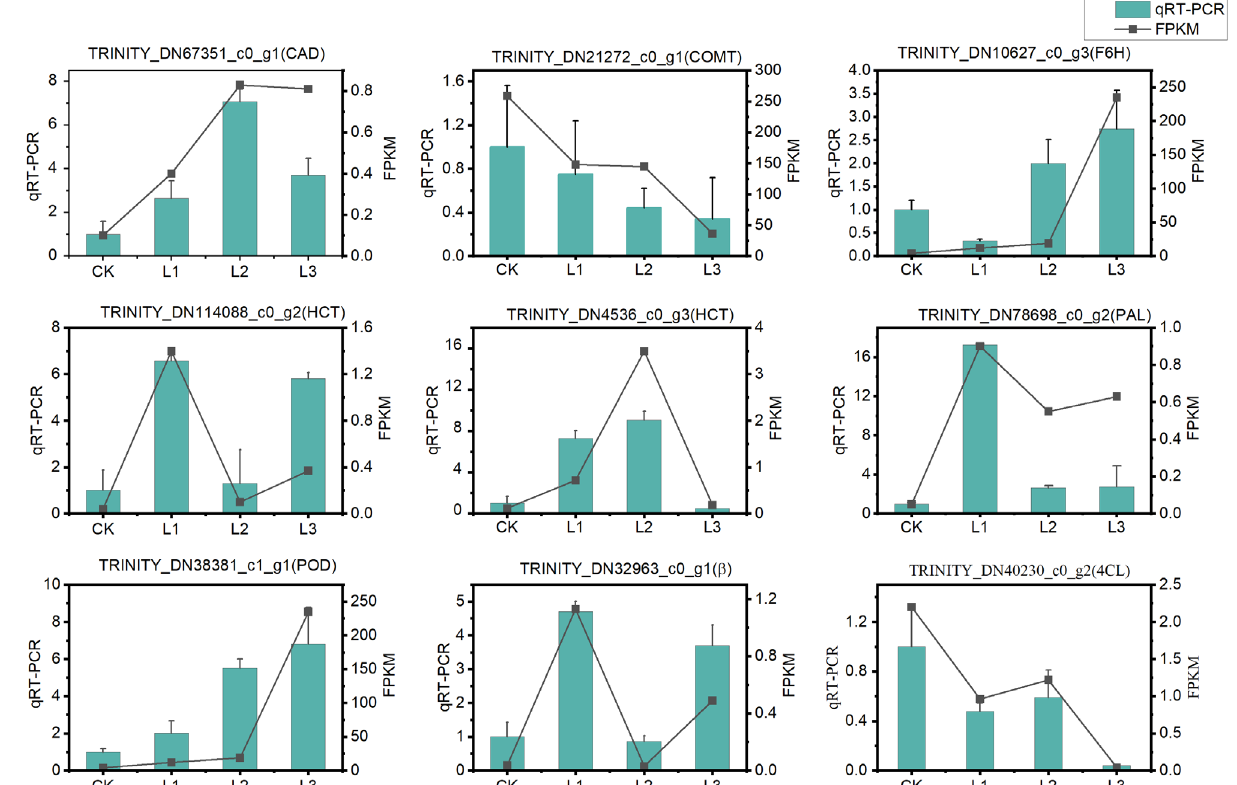
Figure 8. The expression of nine randomly selected DEGs was determined by RNA-seq and qRT- PCR under different light intensities. The y-axis on the left indicates the qRT-PCR expression levels and the y-axis on the right indicates the RNA-seq data with Log2 (FPKM). The x-axis indicates the light treatments.